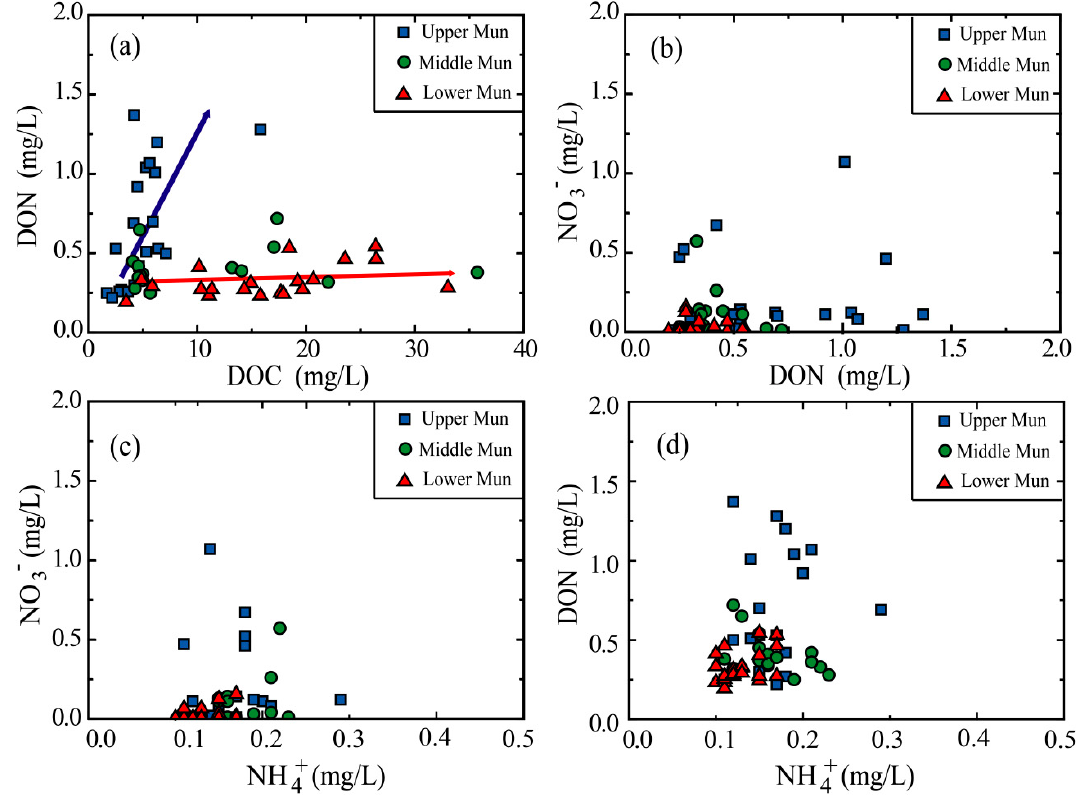
Figure 5. Correlations between the DOC and species: ( a ) DOC vs. DON; ( b ) DON vs. NO 3 − ; ( c ) NH 4+ vs. NO 3 − ; ( d ) NH 4+ vs. DON.